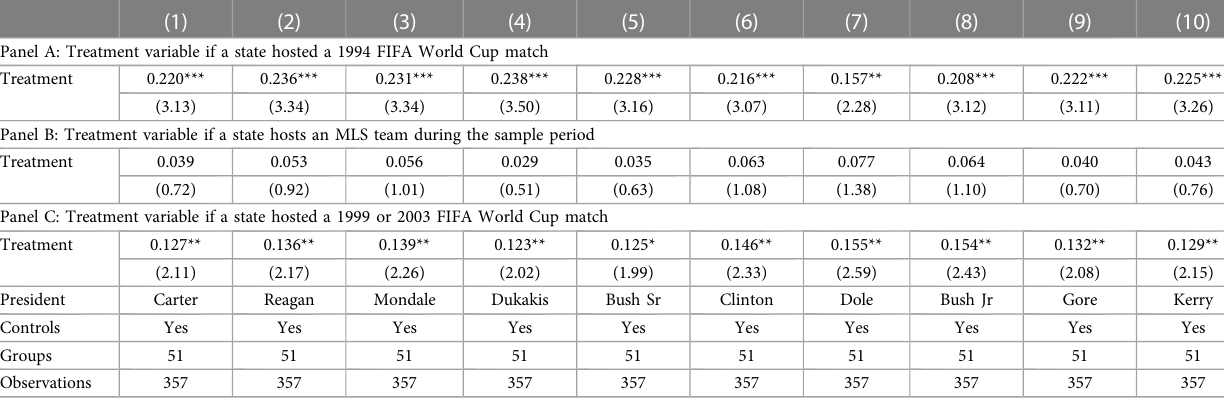
Figure 6 focuses on how the treatment effect changes when interacting it with our second ethnicity variable, the size of the Caucasian population within a state. The results show that as the percentage of Caucasians increases in a treated state, the impact of soccer on the Democratic vote share also increases.